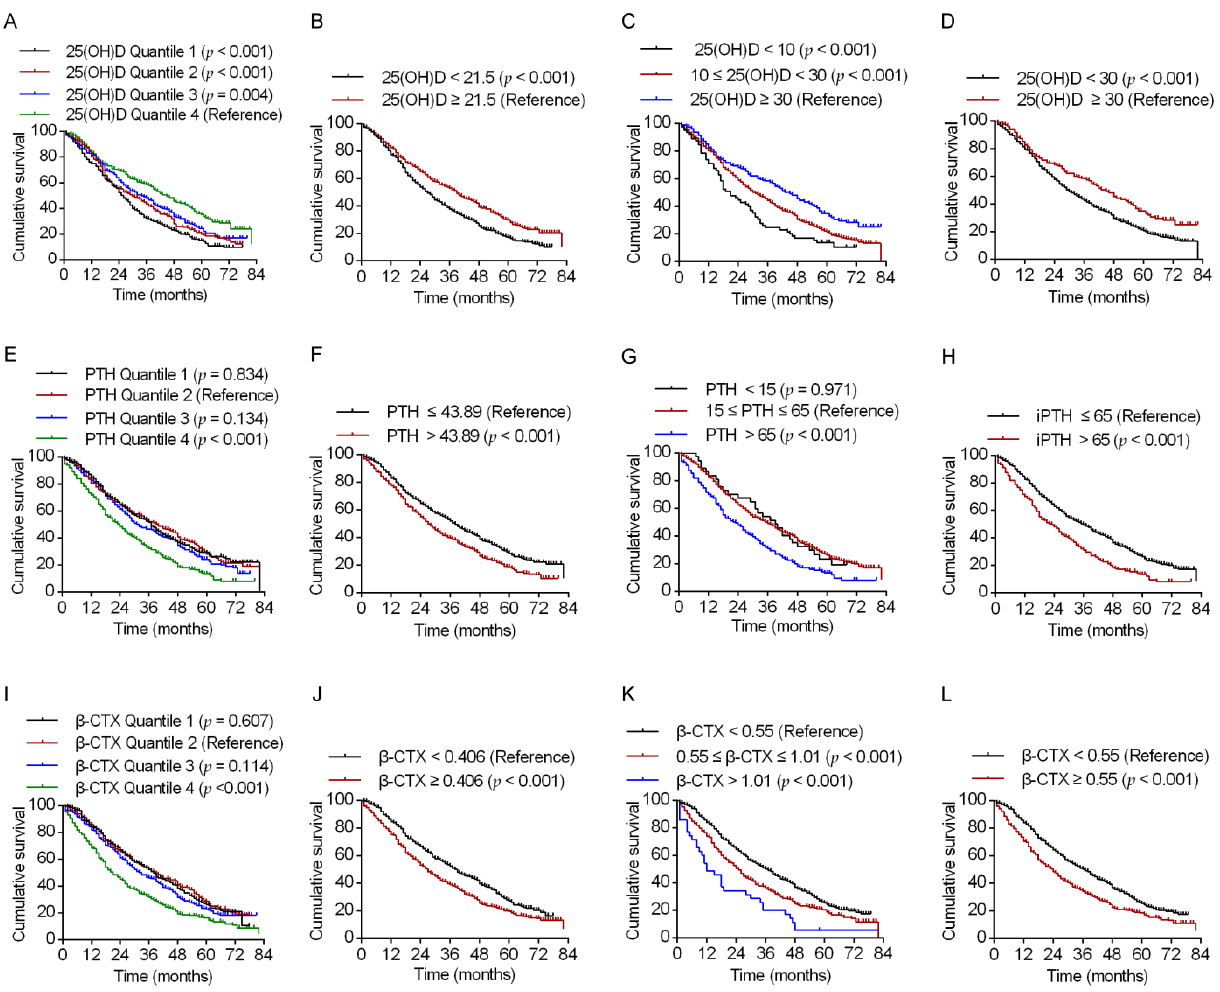
Figure 2. Kaplan–Meier plots and results of the log-rank test for the associations of all-cause mortality with 25(OH)D, PTH, and β -CTX levels. ( A – D ) Serum 25(OH)D (ng/mL) by interquartile, median, and clinical reference values. ( E – H ) Serum PTH (pg/mL) by interquartile, median, and clinical reference values. ( I – L ) Serum β-CTX levels (ng/mL) by interquartile, median, and clinical reference values. 25(OH)D, 25-hydroxyvitamin D; β-CTX, β-C-terminal telopeptide of type 1 collagen; PTH, parathyroid hormone.